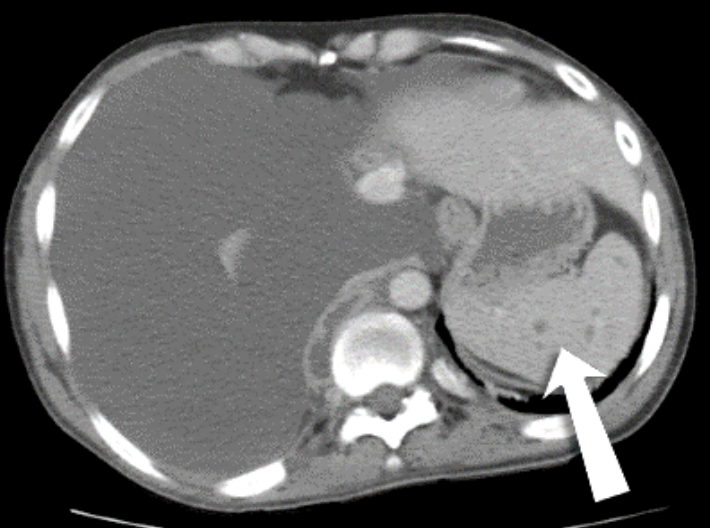
Figure 3. This is an axial view demonstrating the large right pleural effusion as well as multifocal splenic